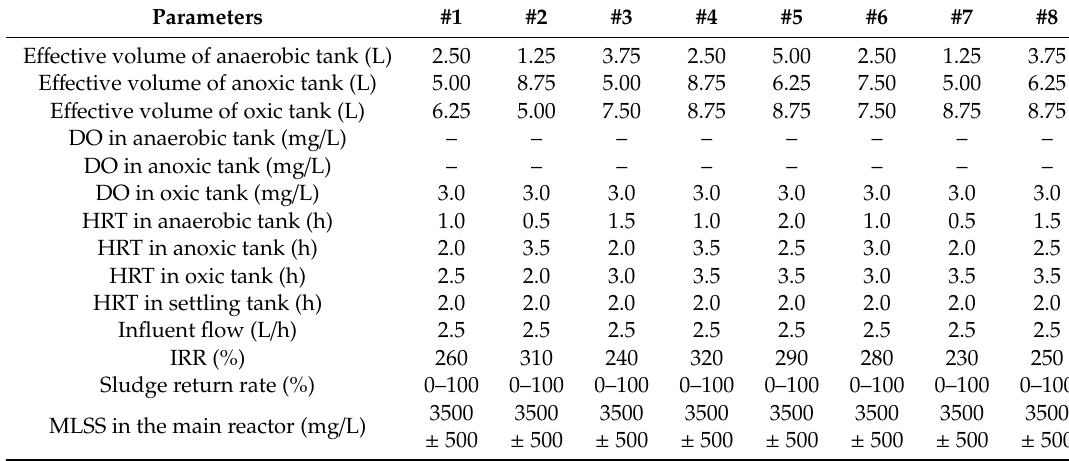
Table 2. Operational parameters and control strategies of the HRTs optimization for #1, #2, ... , #8 AAO